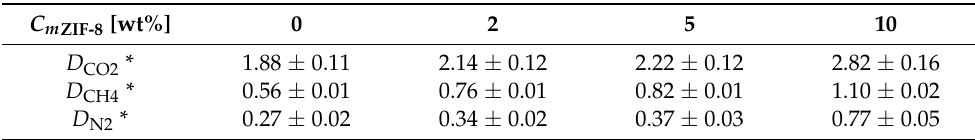
Table A5. Diffusion coefficient D i for membranes of different ZIF-8 concentrations. * The values in table should be multiplied.